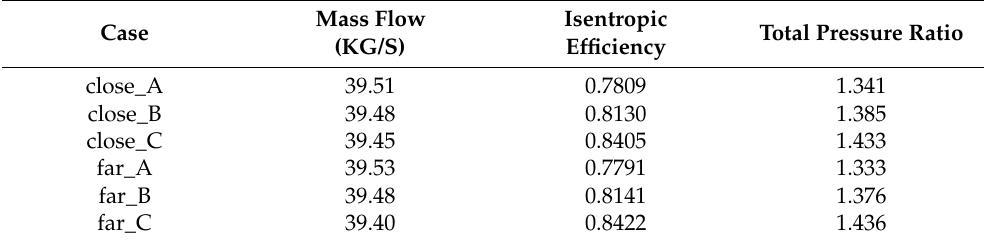
Table 2. The steady performance of two geometry at three operating